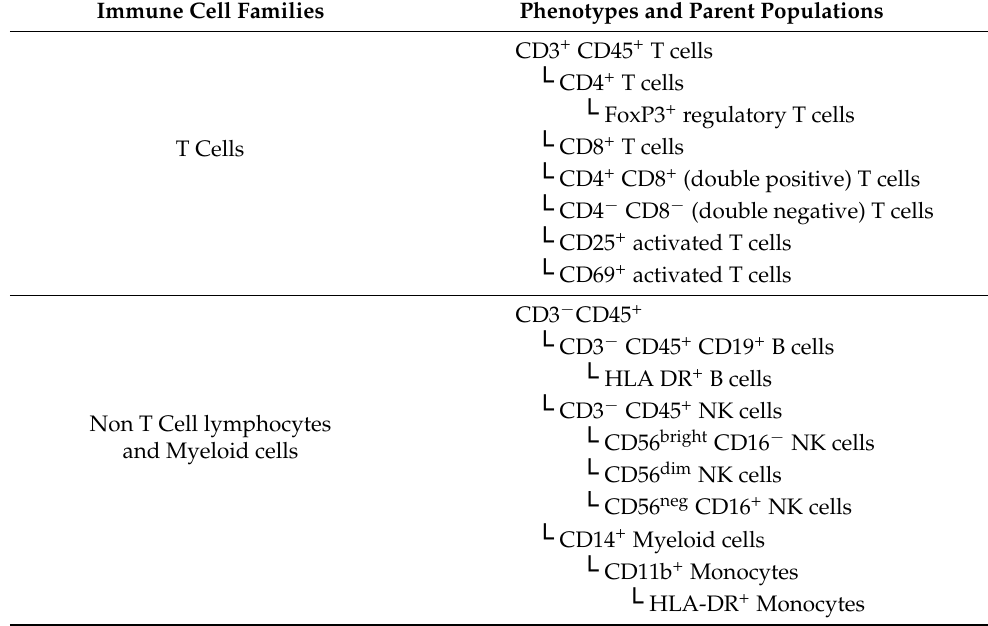
Table 1. Evaluated immune cells phenotypes.